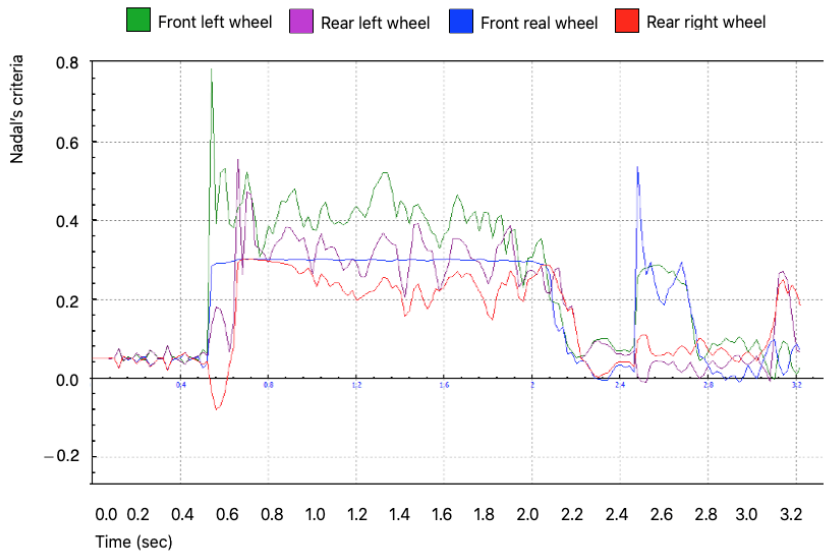
Figure 18. Nadal’s criterion for conventional deflection (L = 3500).